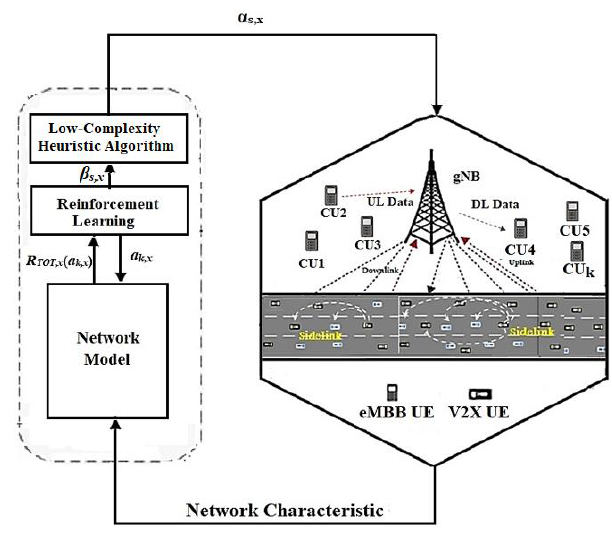
Figure 1. RAN Slicing